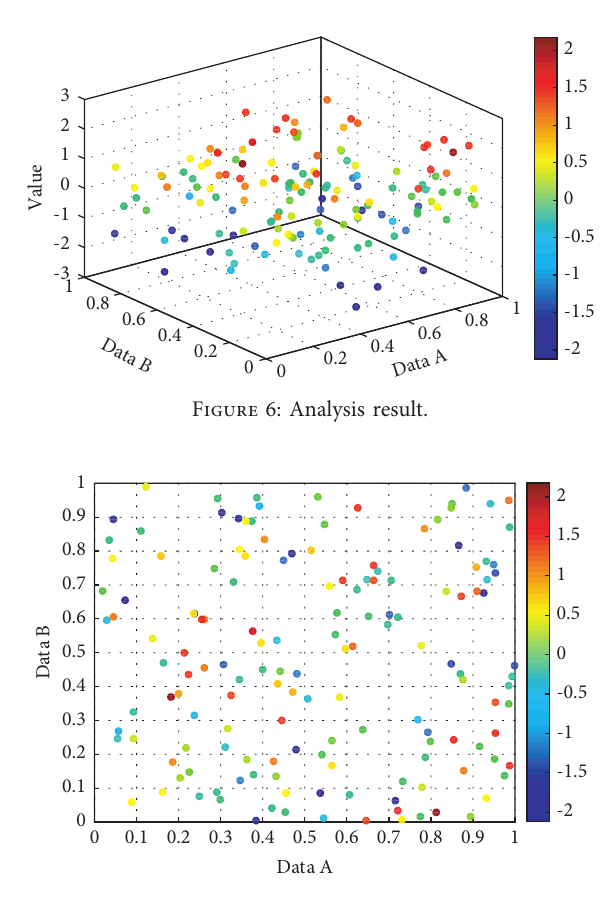
Figure 7: Different data